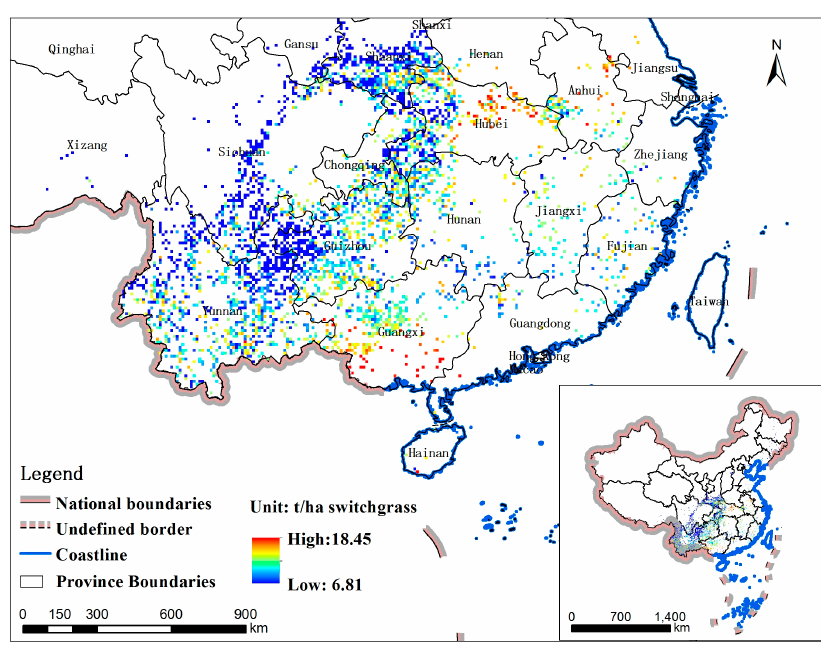
Figure 3. Spatial distribution of switchgrass.